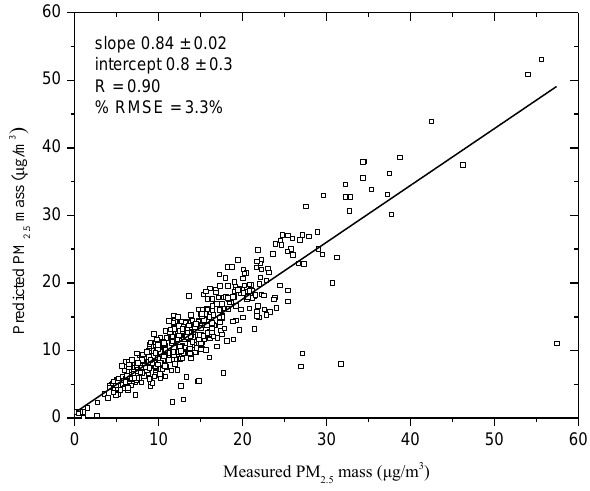
Figure 2. Comparison of measured and predicted mass concentrations of PM 2.5 in Little 2 Fig. 2. Comparison of measured and predicted mass concentrations Rock, Arkansas. 3 of PM 2 . 5 in Little Rock, Arkansas.